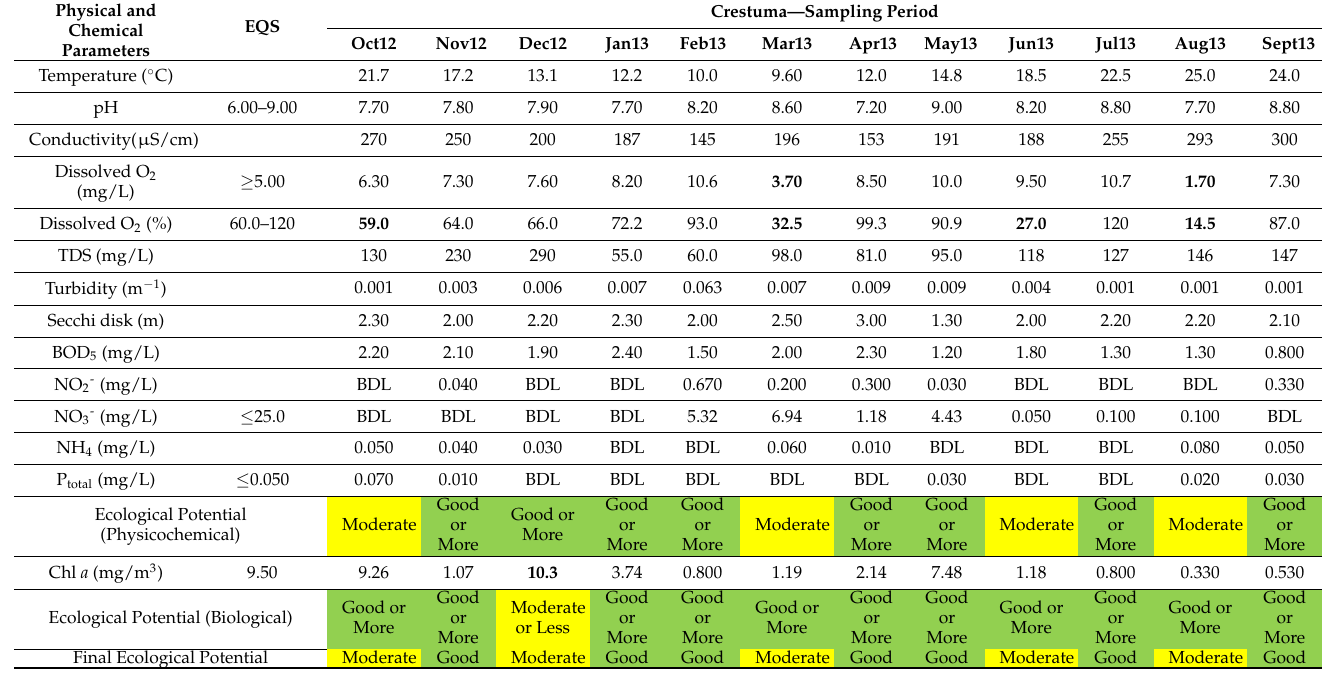
Table 1. Crestuma results of the general physical and chemical parameters measured in situ ,